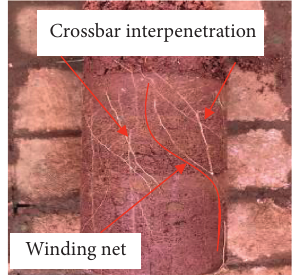
Winding Figure 11: Soil wrapped by